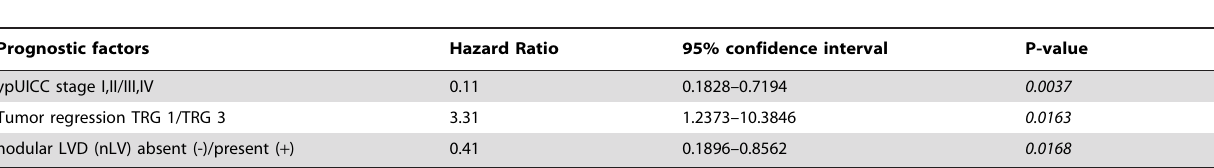
Table 2. Significant relationships as depicted in the multivariate Cox proportional hazard regression model.